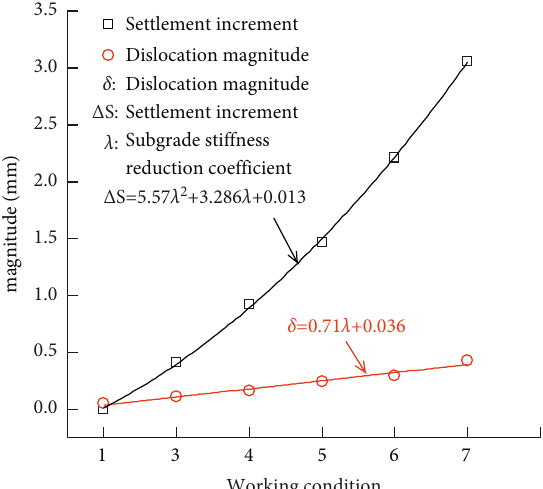
Figure 15: The relationship between the settlement increment and the dislocation